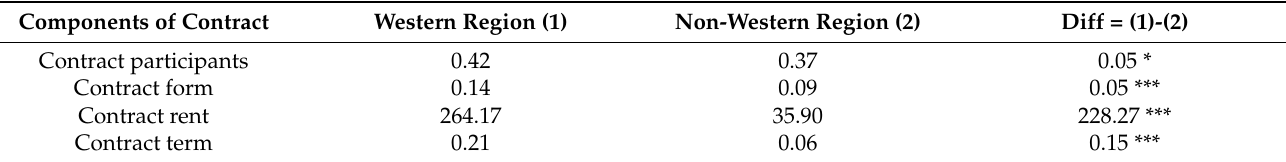
Table A4. The T test of the difference in contract choice between western region and non- western